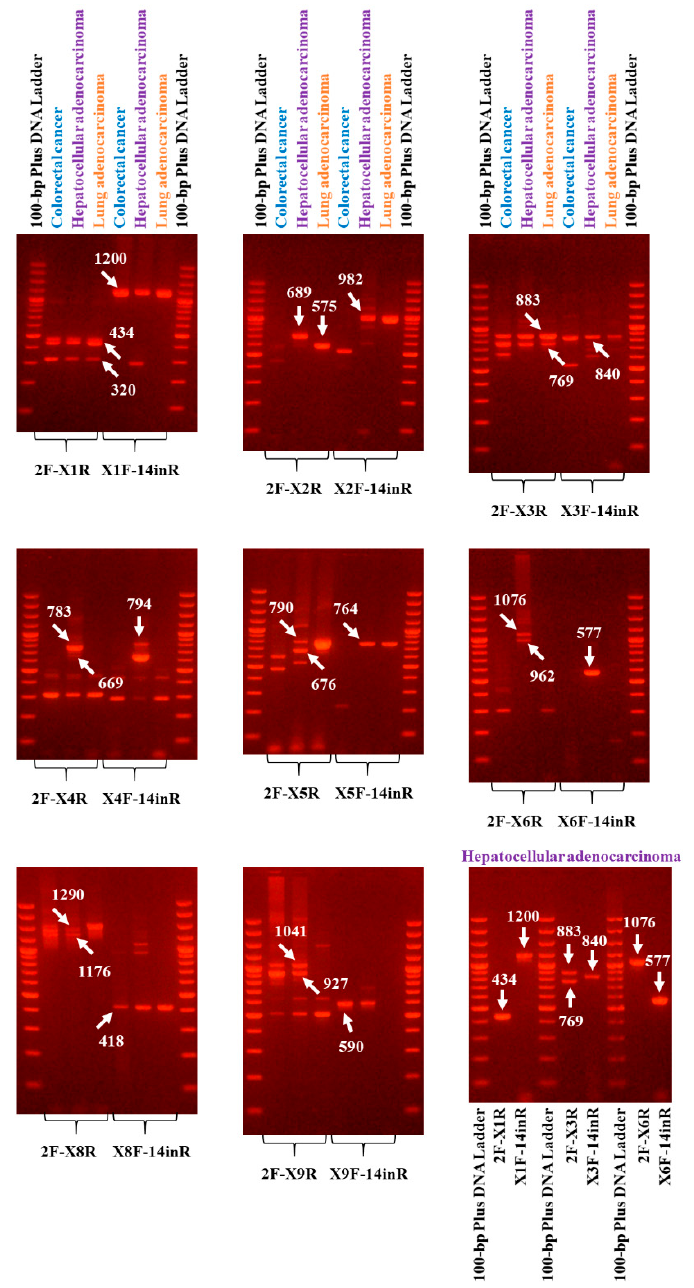
Figure 1. Expression analysis in the 3 cDNA pools derived from colorectal, hepatocellular, and lung cancerous tissues, in which the novel transcripts were more abundant. More specifically, the transcripts with L1 as the first exon containing one of the novel exons (X1 to X9) are shown in the first 8 photos. The transcripts starting with exon N1 are shown in the last photo (bottom right). The pair of primers that was used for the generation of each transcript and the expected product size (s) are written on the panel. The arrows point at each predicted product.